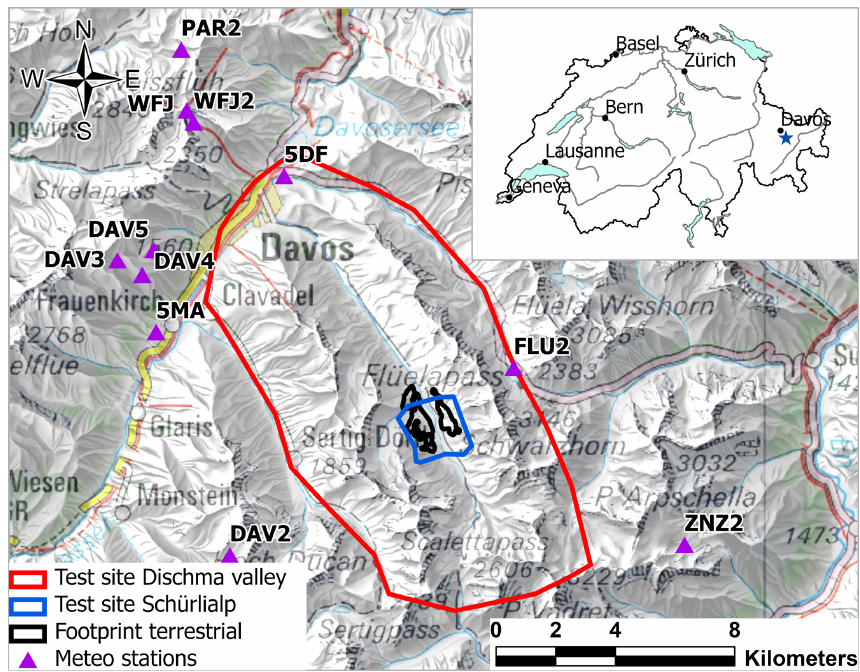
Figure 1. Overview of the test sites: area recorded by the satellite and airplane imagery (red), area covered by the UAS imagery (blue) and area covered by the terrestrial images (black). The purple triangles represent the location of automatic and manual snow measuring stations around Davos. The abbreviations correspond to the snow measuring stations shown in Fig. S1. The blue star in the inset map shows the location of the Schürlialp test site (Swiss Map Raster, source: Federal Office of Topography).